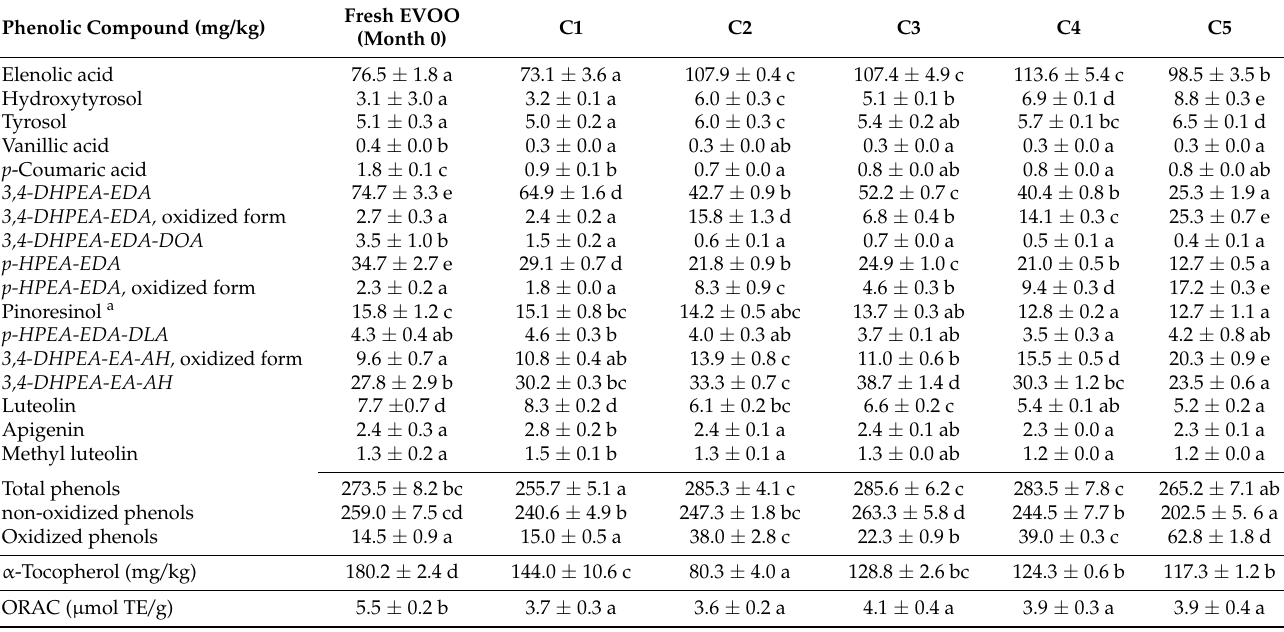
Table 2. Content of phenolic compounds, α -tocopherol, and antioxidant capacity after 12 months of storage under different conditions. Phenolic Compound